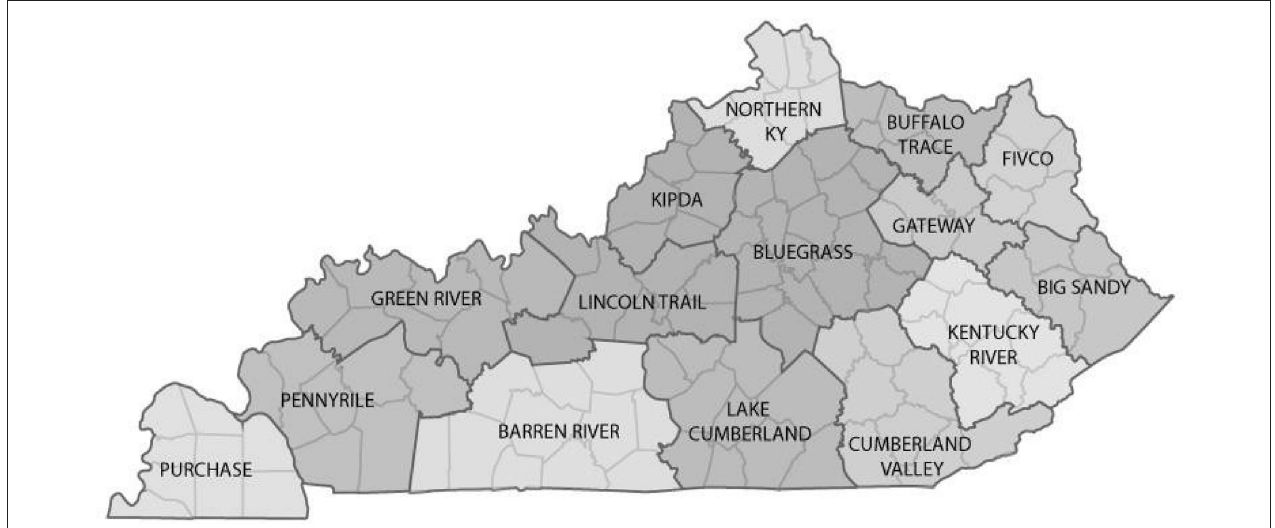
FIGURE 1 | Ten counties of the Barren River Area Development District.